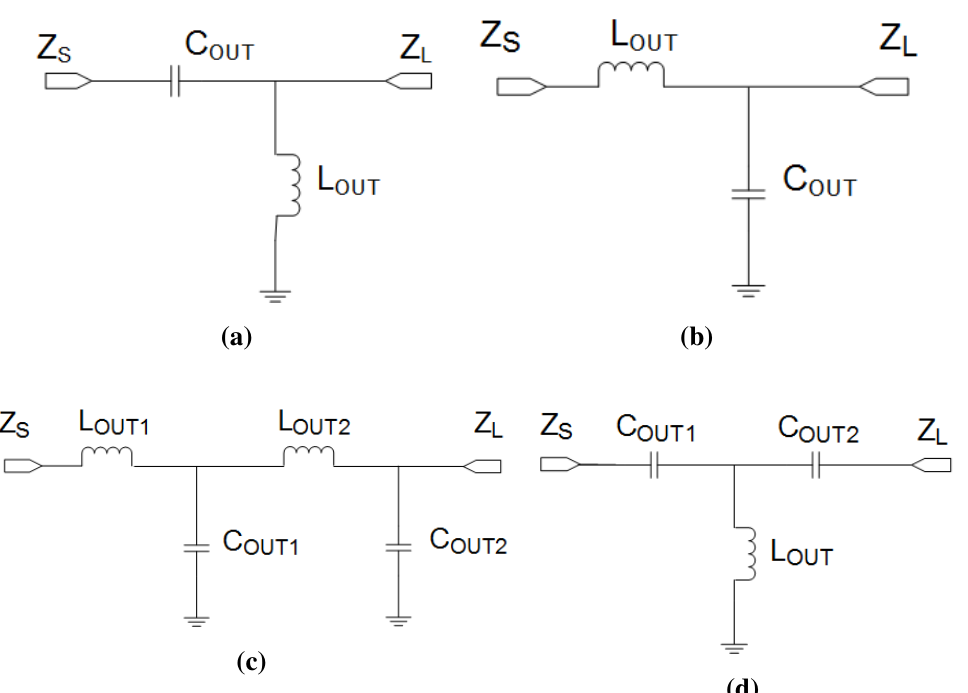
Figure 10. Four possible output matching networks for the Class AB power